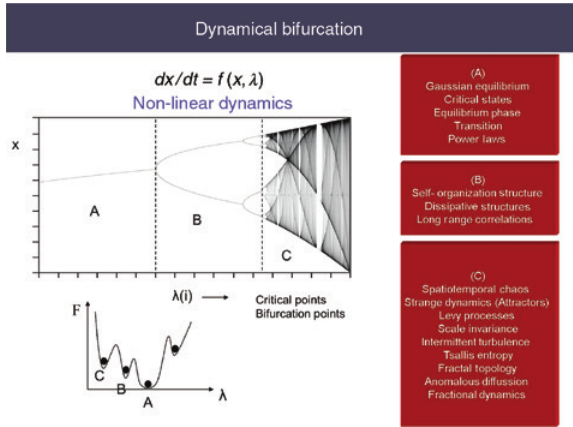
Figure 1: This figure decribes the basic scenario toward the devel- opment of complexity and emergence of complex structures as the control parameters λ increases. For weak coupling (low values of λ ) the system lives near thermodynamical equilibrium (region A), where free energy obtains the absolute minimum. As the coupling of the system with its envriromnet becomes stronger by increasing the control parameters λ the system passes through bifurcation points and develops complex structures with strong space-time correla- tions. Far from equilibrium, the system lives at local minimus of free energy where it appears complex-dissipative structures, fractional dynamics and Tsallis